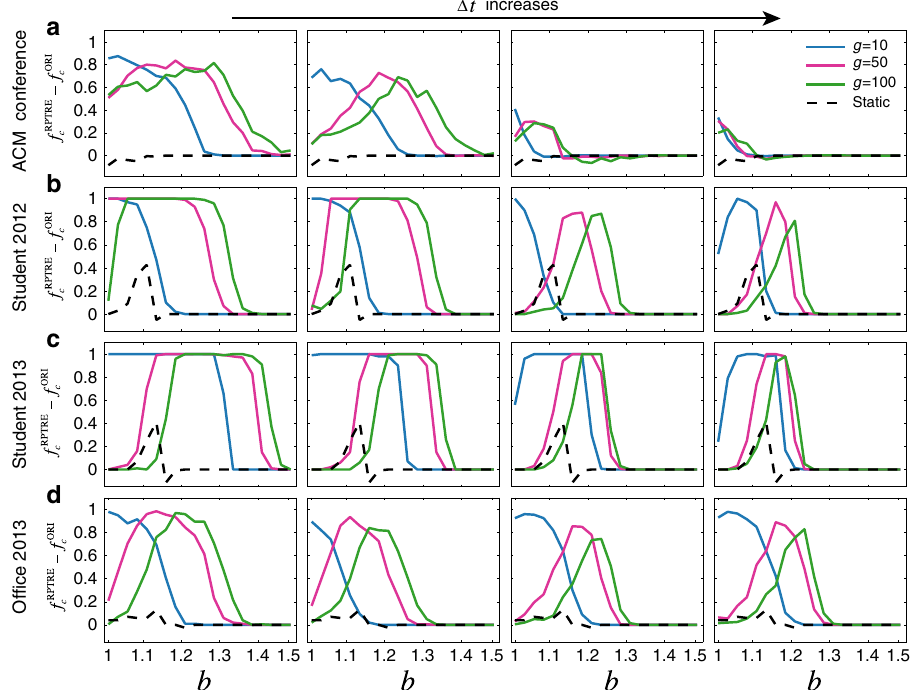
Fig. 4 The intrinsic bursty behaviour in human interactions suppresses the maintenance of cooperation. For each dataset, we show the difference f RPTRE between the frequency of cooperators f RPTRE in temporal networks generated from each datsaset after randomly permuting both the (cid:2) f ORI c c c timestamps and edges (RPTRE) which erases the burstiness inherent to human interaction data (see Methods), and f ORI